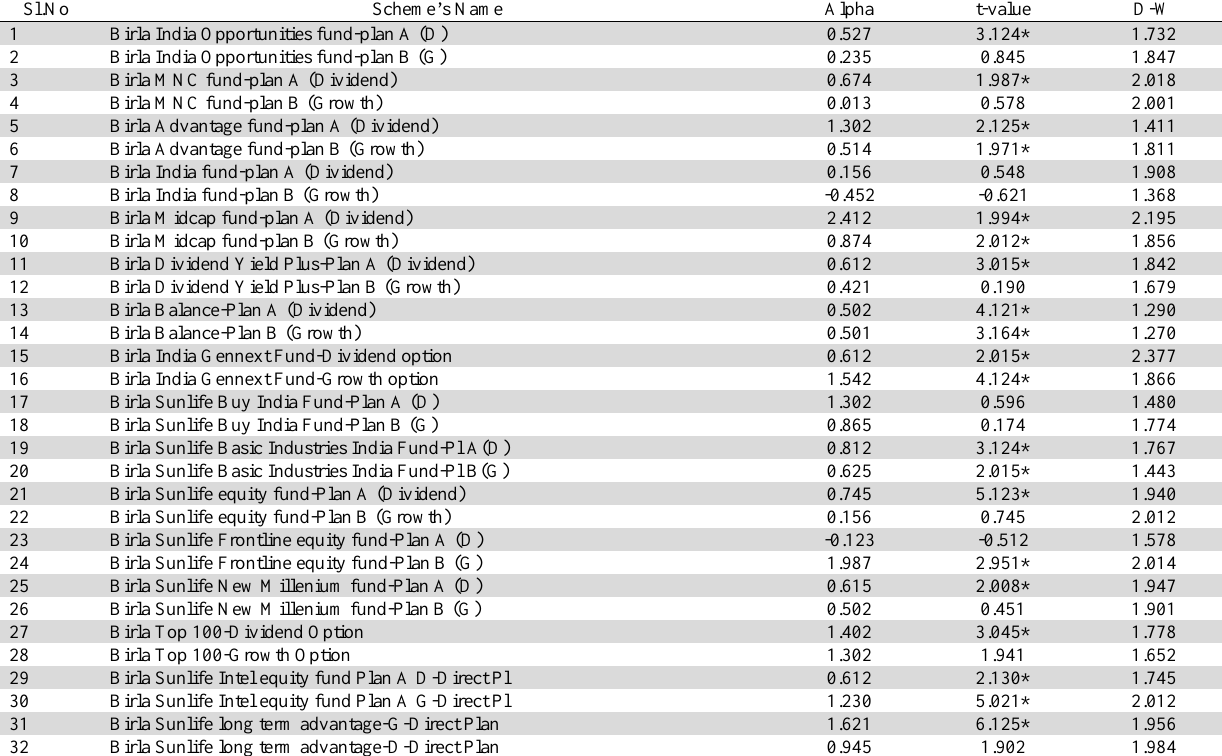
Estimation of selectivity performance by conditional measure of Jensen